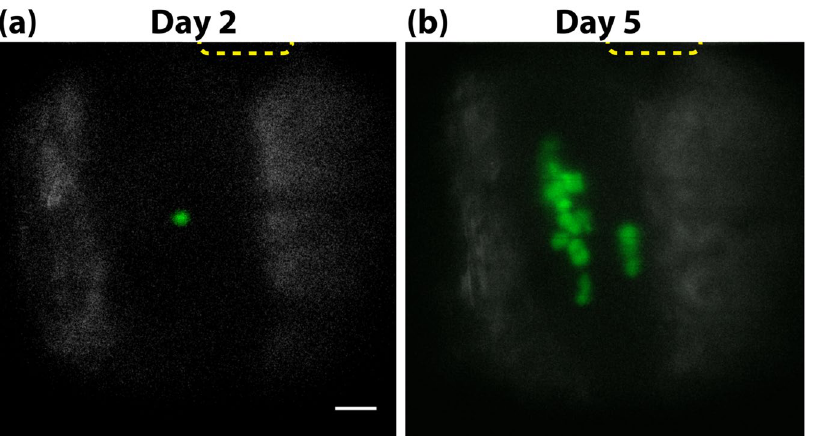
Figure 4. Monitoring local proliferation after single HSPC transplantation. ( a ) Image taken near the delivery site 2 days after transplantation of a single LKS cell into the BM. The image was taken ~100 µ m below the bone surface. ( b ) The same location imaged 5 days after the transplantation. To improve image quality the bone was thinned down to ~15 µ m. White: SHG, Green: GFP. Scale bar 50 μ m. The dotted squares at the top of the images indicate the location of the laser microsurgery, i.e. the delivery site.